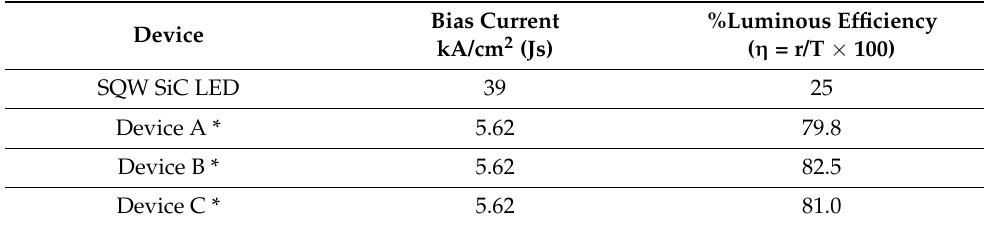
Table 4. Comparison of the luminous efficiencies of simulated. SiC LED with the literature [50].